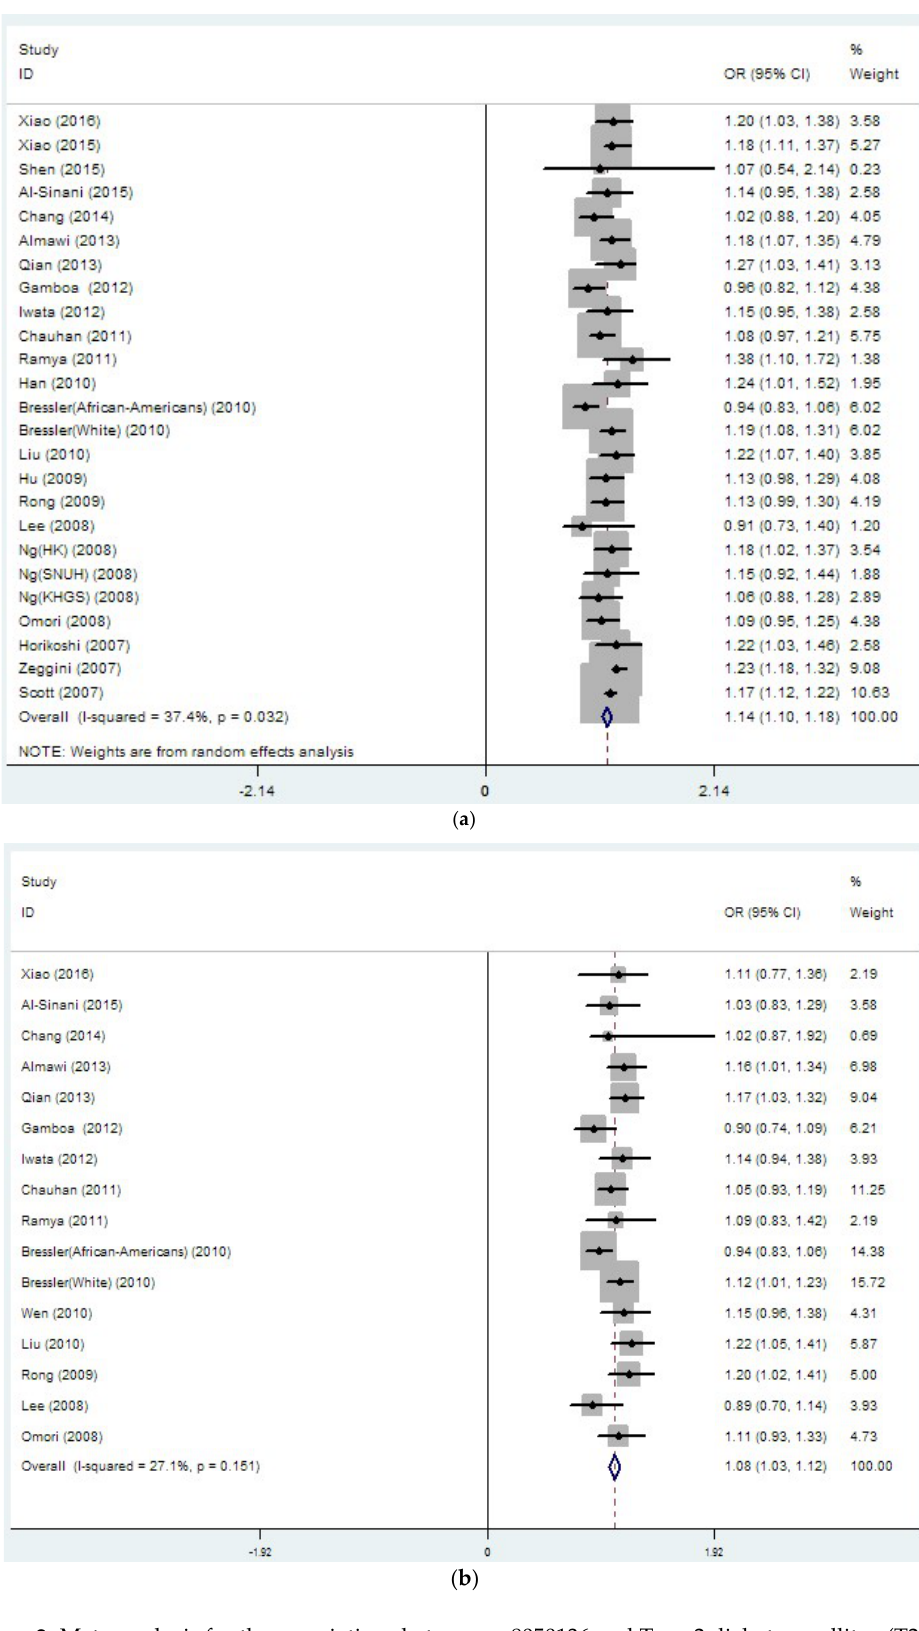
Figure 2. Meta-analysis for the associations between rs8050136 and Type 2 diabetes mellitus (T2DM) risk: ( a ) without; and ( b ) with adjustment for body mass index (BMI).